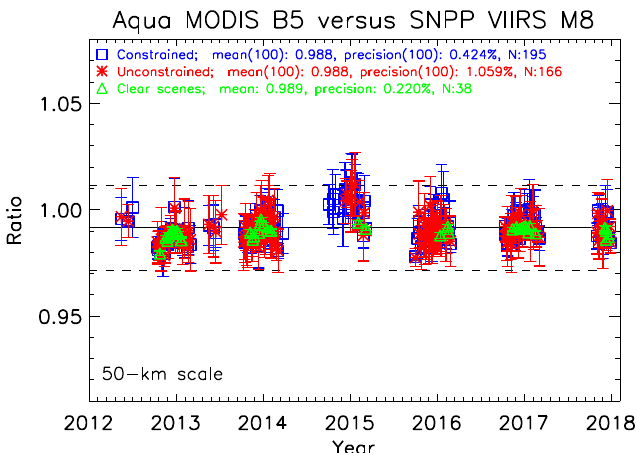
Figure 10. The three time series of Aqua MODIS B5 versus SNPP VIIRS M8 correspond to the constrained analysis using homogeneity and sample size constraint, the unconstrained case, and the clear-scene result.